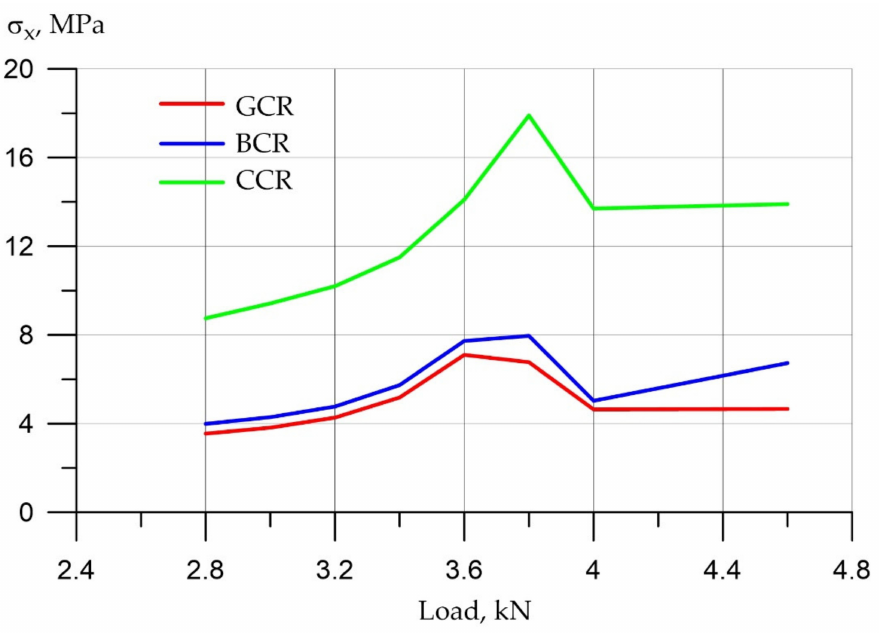
Figure 12. Compressive stresses in various types of